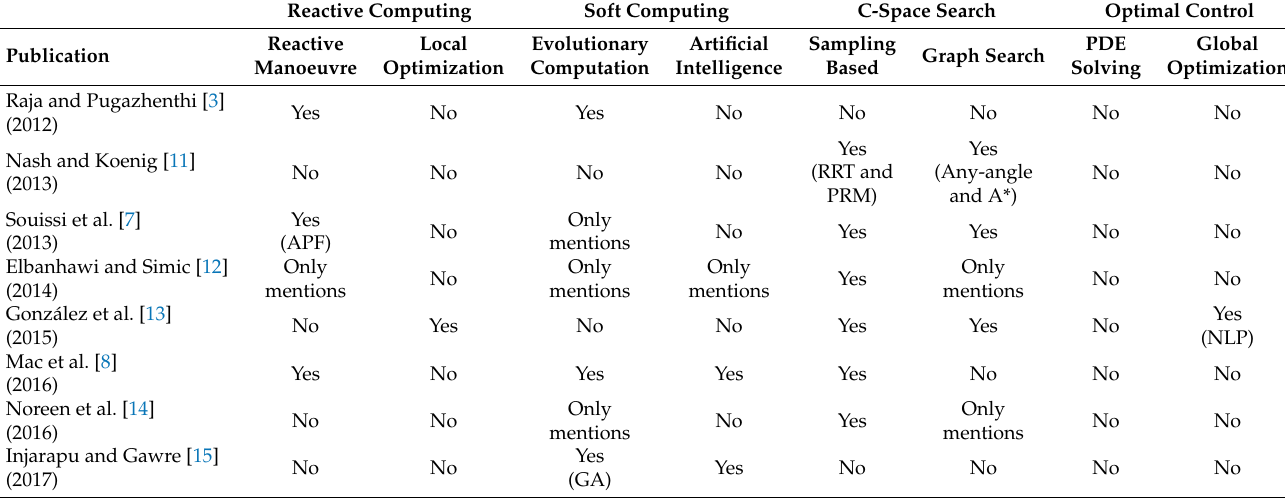
Table 1. Main surveys and reviews of global path planning algorithms found in the literature. Reactive